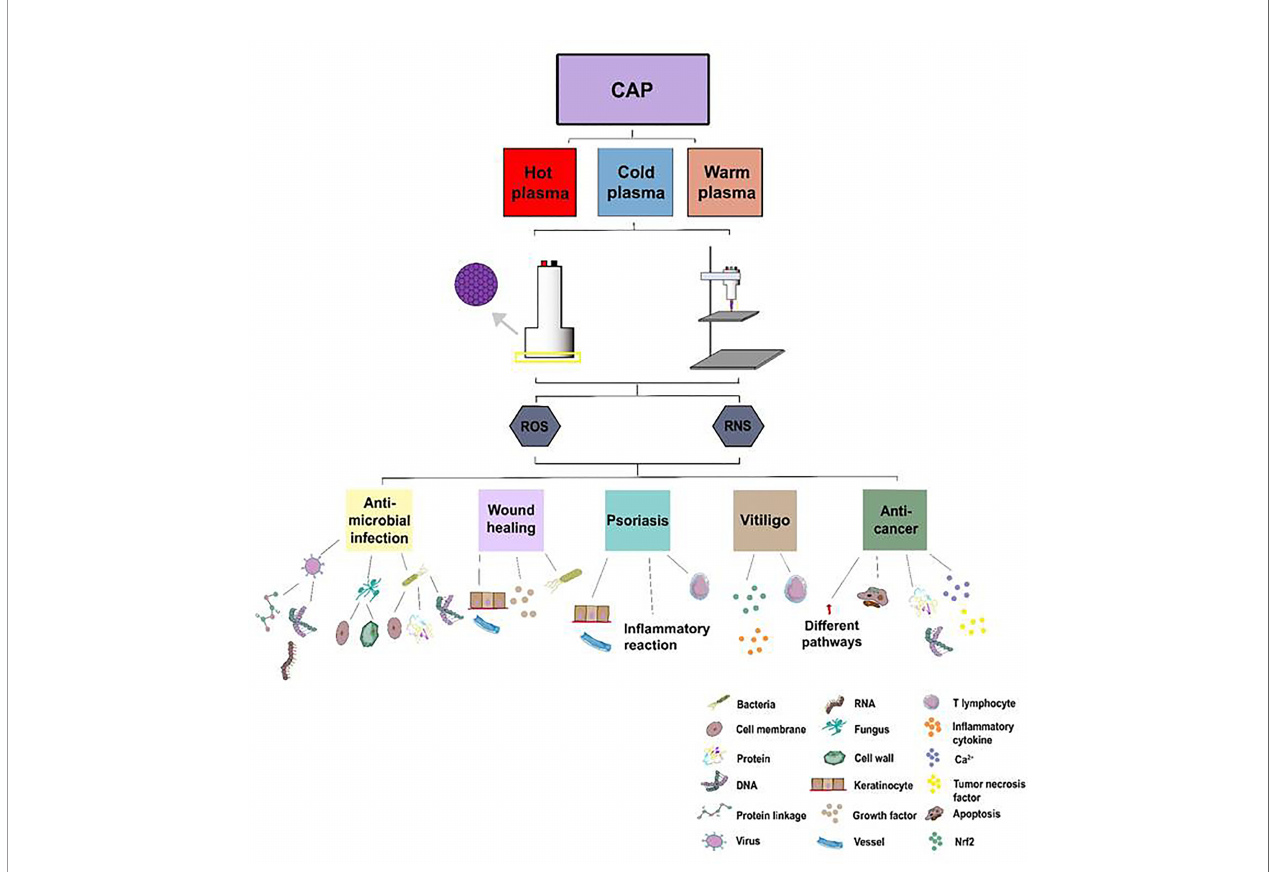
FIGURE 7 | The treatment of CAP application on skin diseases. Atmospheric plasma has been divided into hot, warm, and cold atmospheric plasma. Two main kinds of CAP generators, DBD and APPJ, have been utilized to treat skin diseases such as inactivating microorganisms, accelerating wound healing, ameliorating ncISDs, and inhibiting tumors via ROS and RNS from